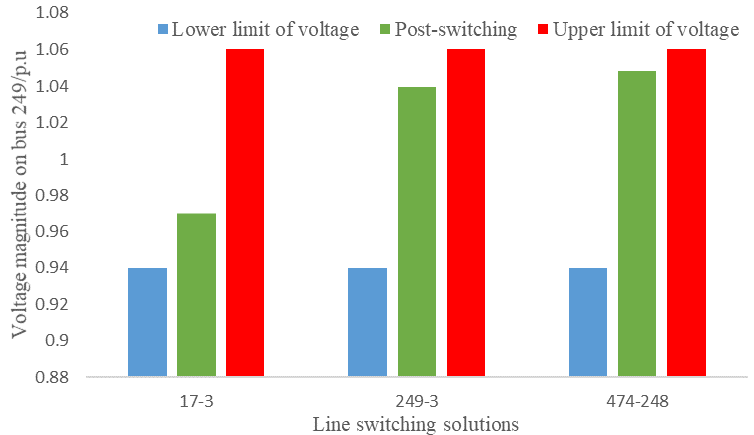
Figure 10. The voltages of bus 249 for the pre-switching and post-switching systems.